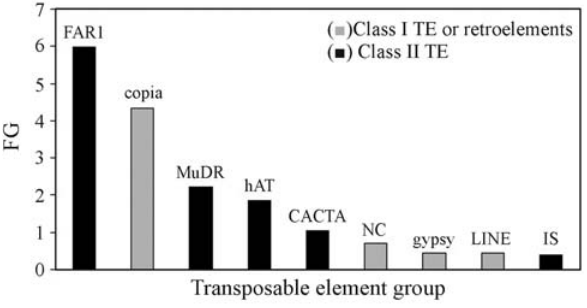
Figure 1 - Frequency of different groups of TE in Eucalyptus (FG). Values in Table 2 were converted to frequency values within each of the groups of TE as described in the text. nc: non-classified LTR.